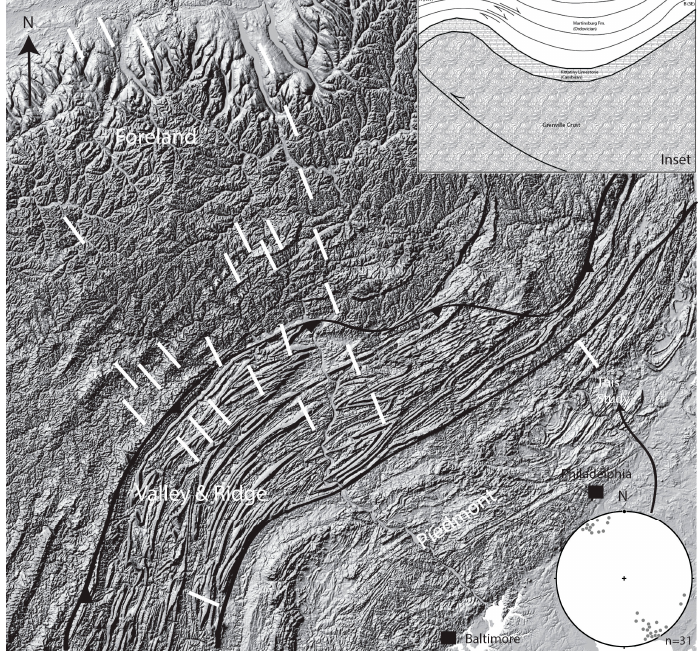
Figure 7. Strain data for the Piedmont, Valley and Ridge, and Foreland provinces across the central Appalachian Mountains and the Pennsylvania Salient orocline. Sources are [8,10,24,25,44,45,85] and this study. Stereonet is a summary plot of calcite twinning shortening axes. Inset is a schematic of a flexural-slip interpretation of Figures 2a,b and 3a,b and the Solor Church folds. Calcareous siltstone layers (<0.5 m) are infrequent within the Martinsburg Fm. and are part of the Ordovician turbidite sequence. These layers are geochemically different than the enclosing turbidites (Table 3) and there is literature about non-tabular clastic enclaves and dikes in the Martinsburg Fm. [4–6,86]. Isotopic values for calcite veins in this siltstone layer are similar to the other syn-orogenic calcite fluids (Table 1) and the twinning strains correlate well within the multi-layer sample and with twinning strain results across the syncline (Figure 4). Shear between the Martinsburg turbidite and calcareous siltstone demonstrates the rheological difference between these materials relative to the contemporaneous cleavage and the presence of minor folds in the Stone Church syncline. Internally, the fine-grained calcite in the silty layer has a preferred orientation parallel to the inferred Taconic shortening orientation (Figures 2 and 4) but normal to bedding. The calcareous siltstone layer LPO strain proxy and calcite vein twinning shortening strain are sub-horizontal and oriented SE–NW, and both preserve a layer-normal shortening suggesting the strain was imposed in these rocks after the bedding was folded into a sub-vertical orientation as part of the Stone Church syncline. The calcite shortening strain here is parallel to the cleavage dip direction and the extension axis is vertical. The contrived NEV calcite twinning overprint ( n = 26) preserves a sub-horizontal shortening strain that is parallel to the Stone Church syncline axis, which is roughly parallel to the strike of normal faults on the margin of the Triassic Newark basin